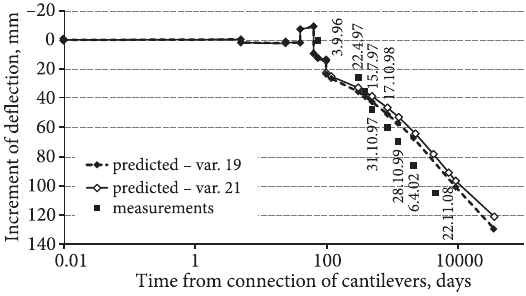
fig. 5. Relative deflection at